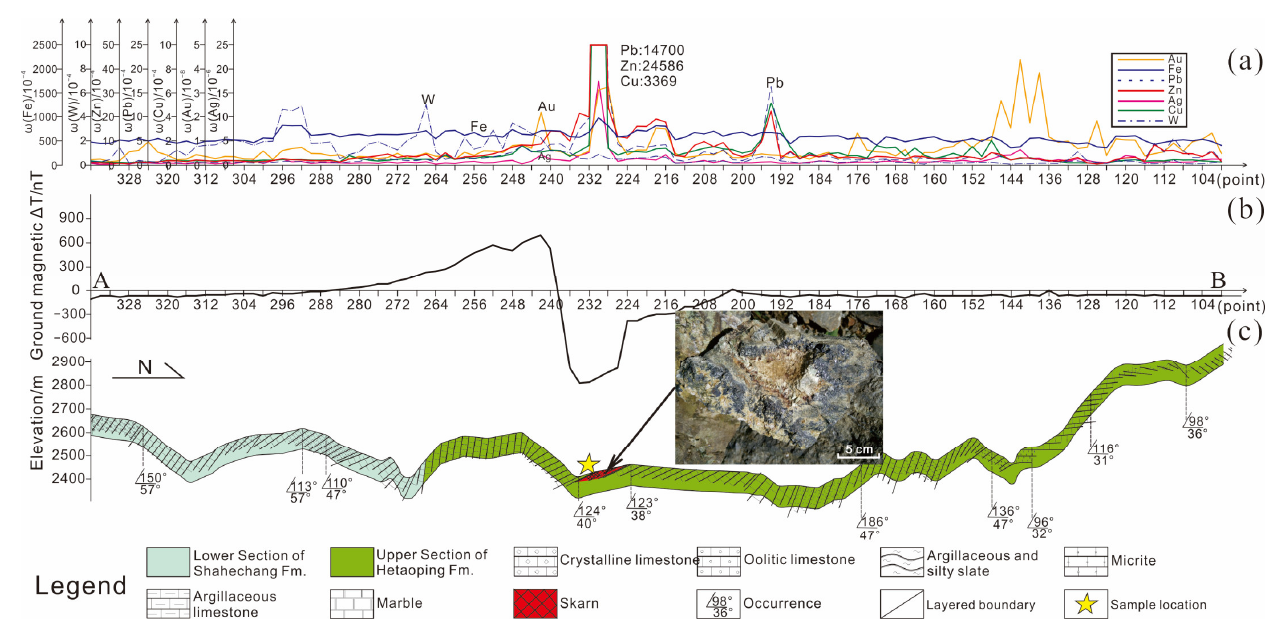
Figure 4. Integrated geological, geophysical, and geochemical survey sections along Line AB. ( a ) Geochemical survey section. ( b ) Ground magnetic survey section. ( c ) Geological survey section. The ore photo in Figure 4c shows the mineral distribution roughly.